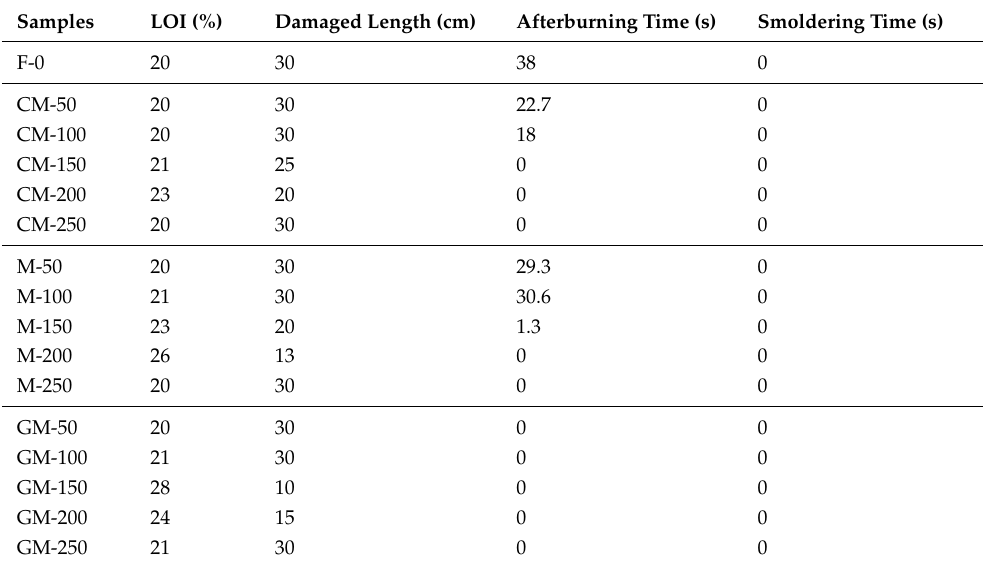
Table 5. The flame retardant property of the